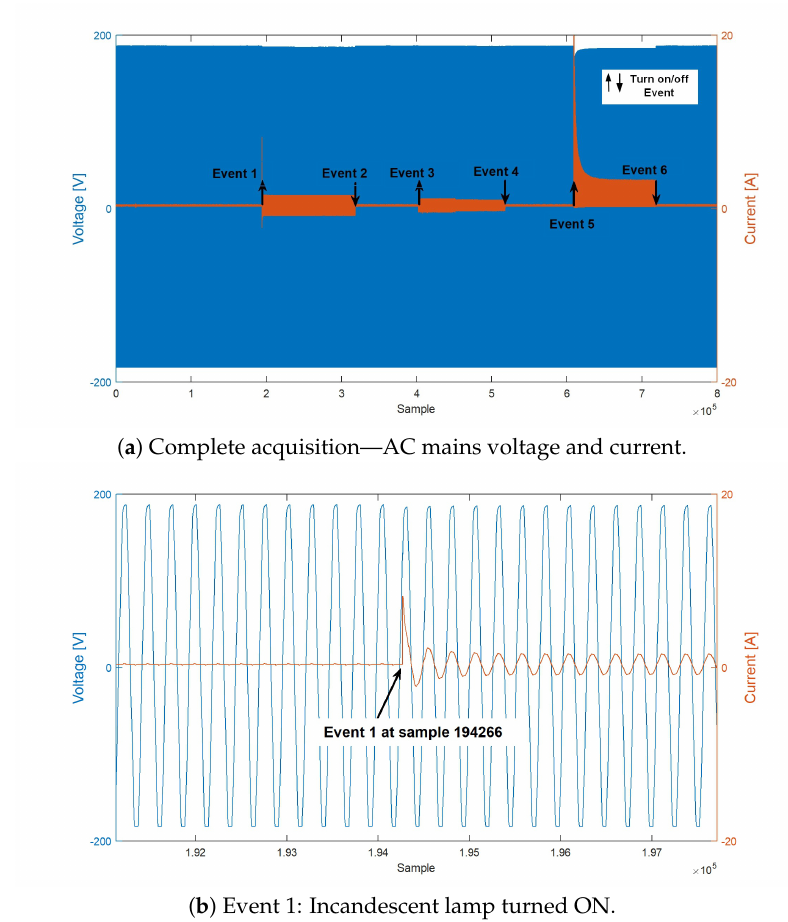
Figure 22. Natural subset: incandescent lamp, LED lamp, and